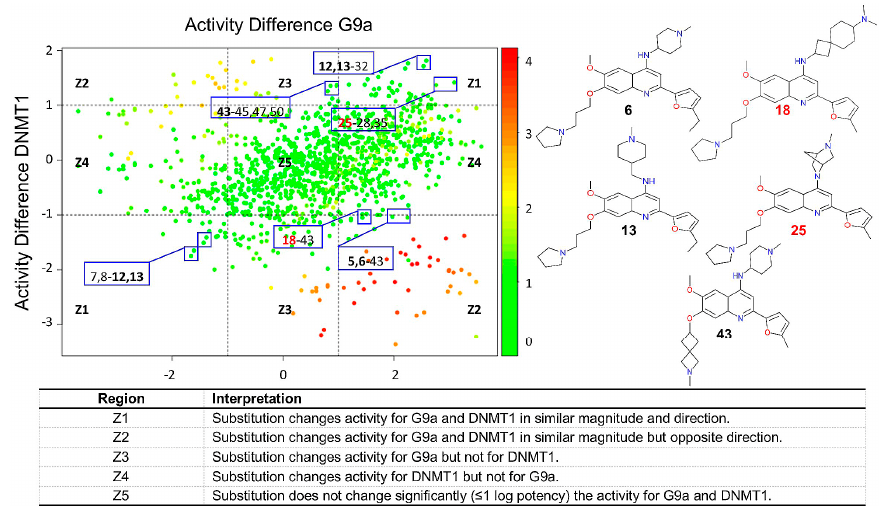
Figure 5. DAD map of compounds with dual activity against G9a and DNMT1. Data points are colored by SALI value. The chemical structures of selected compounds are shown.